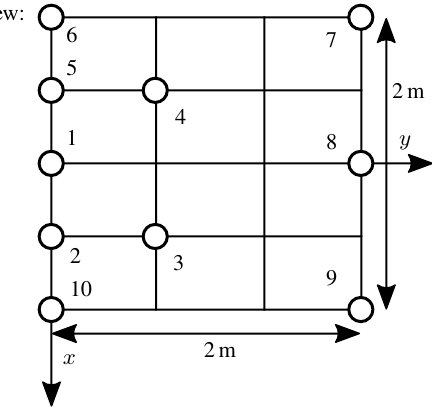
Figure 4. Progression of the force during contact establishment, Figure 6. Investigated points for contact establishment Figure 8. Experimental evaluation of the contact establishment at different positions.